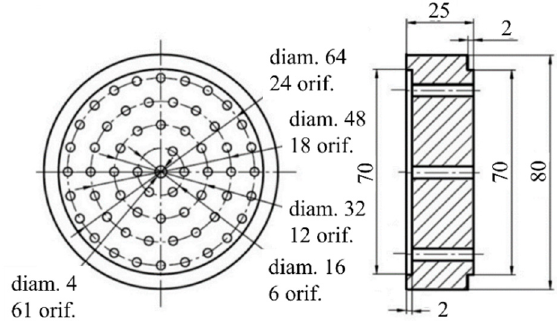
Figure 4. Schematic of the polypropylene block. Dimensions are in millimeters.